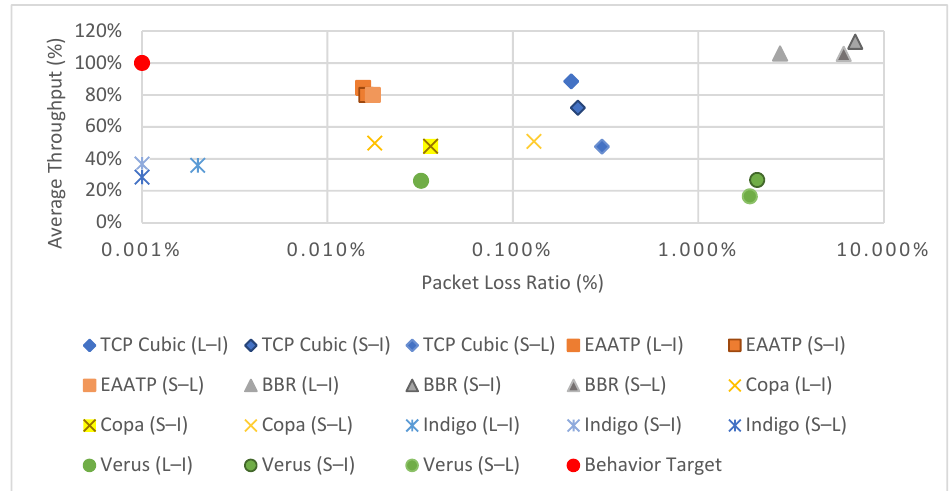
Figure 2. Results of average throughput (%) vs. packet loss ratio (%) of the transport protocols tested in previous work [11]. To represent the graph in semilogarithmic scale, the packet loss ratio values of 0% are represented as 0.001% in the graph. Each transport protocol was tested in three LFN scenarios: London to Iowa (L–I), Sidney to Iowa (S–I), and Sidney to London (S–L).